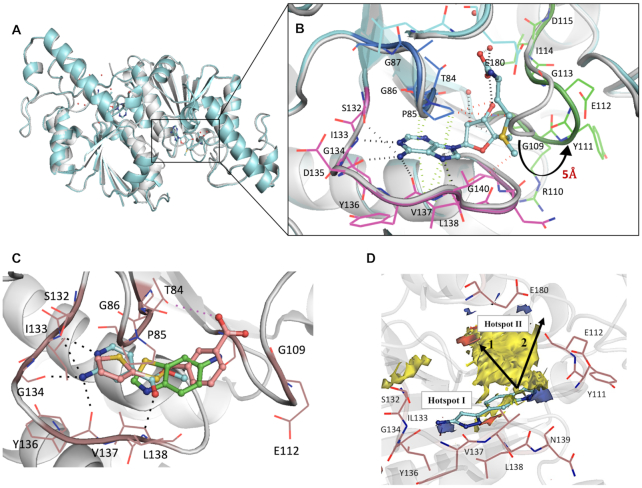
(A) Structural superposition of TrmD apo form (white) and TrmD SAM bound form (light blue), PDB codes 6NVR and 6NW6 respectively (B) the trefoil-knot active site of TrmD involving: cover loop (residues 84–87) shown in dark blue and bottom loop (residues 132–140) in magenta and wall loop (residues 109–115) in green and the conformational flip of the wall loop (residues 109GRYEGID115) upon SAM (light blue stick) binding are illustrated. The residues corresponding to each loop region are also shown as line representation. (C) Three representative fragment hits from each cluster, fragment 14 (PDB Code 6QOK) coloured in blue, fragment 20 (PDB Code 6QOQ) in green and fragment 8 (PDB Code 6QOE) in salmon respectively, occupying the TrmD SAM binding site. Major Hydrogen bonds and electrostatic interactions are depicted in black and purple dotted lines respectively. (D) Hot spot map contoured at 14 of TrmD active site superposed with crystal structure of TrmD in complex with merged compound AW1 (light blue stick). Donor, acceptor and hydrophobic regions of the map are depicted as blue, red and yellow regions respectively. Amino acid residues contributing towards interactions in each hotspot map region are shown as brown stick representation. The arrows indicate two potential ways of fragment elaboration.